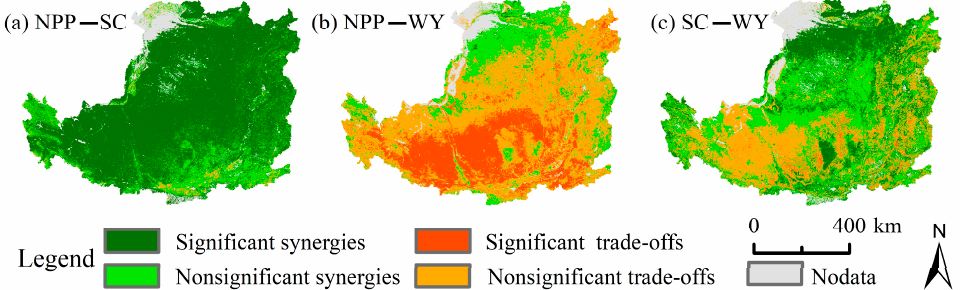
Figure 4. Trade-offs and synergies between different ESs (Note: ( a ) is the relationship between NPP and SC; ( b ) is the relationship between NPP and WY; ( c ) is the relationship between SC and WY).